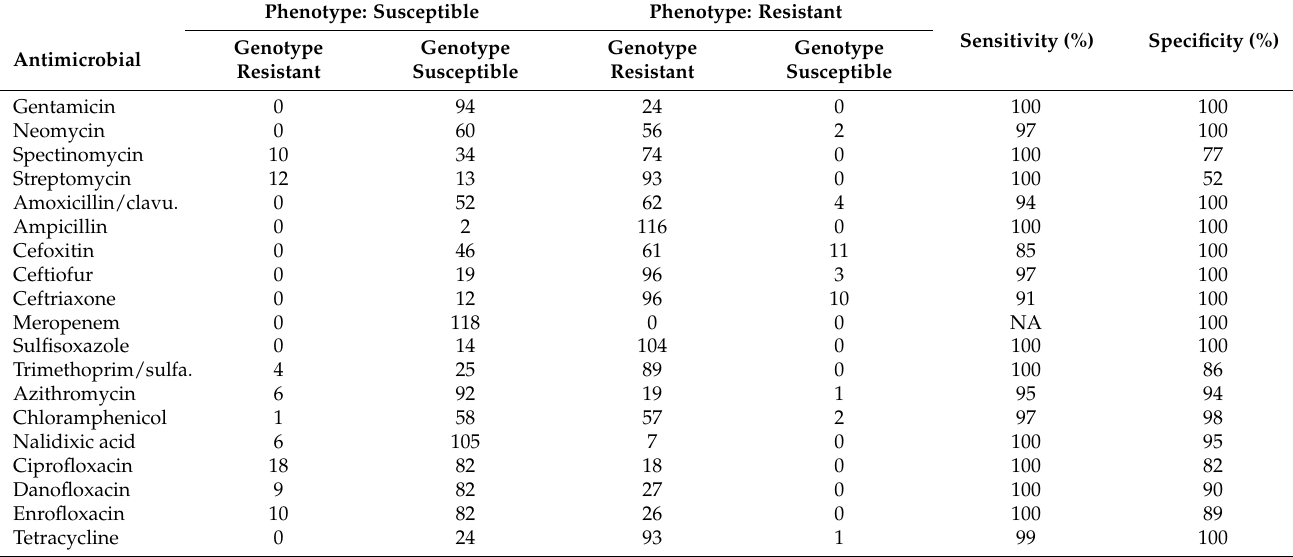
Table 3. Agreement (number of isolates) observed between antimicrobial resistance phenotypes and genotypes for a selection of the most resistant Escherichia coli ( n = 118) isolated from manure at 101 dairy farms in Qu é bec, Canada.